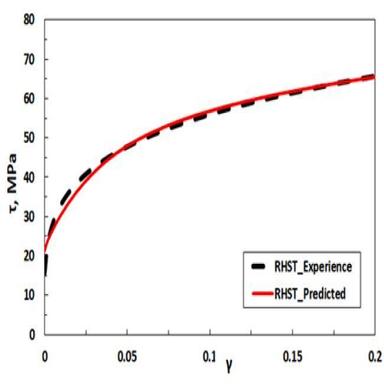
Shear stress vs. shear strain curves: experimental and the Hill48 analytically predicted.